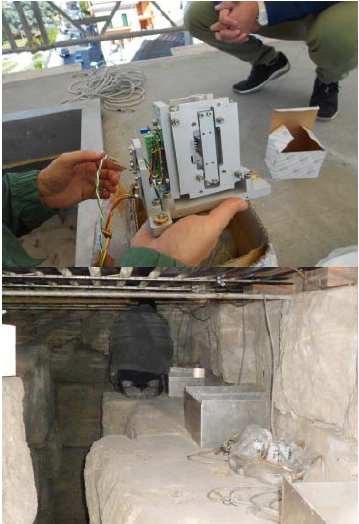
Figure 10. Installation of accelerometers, on the Attic of Trajan